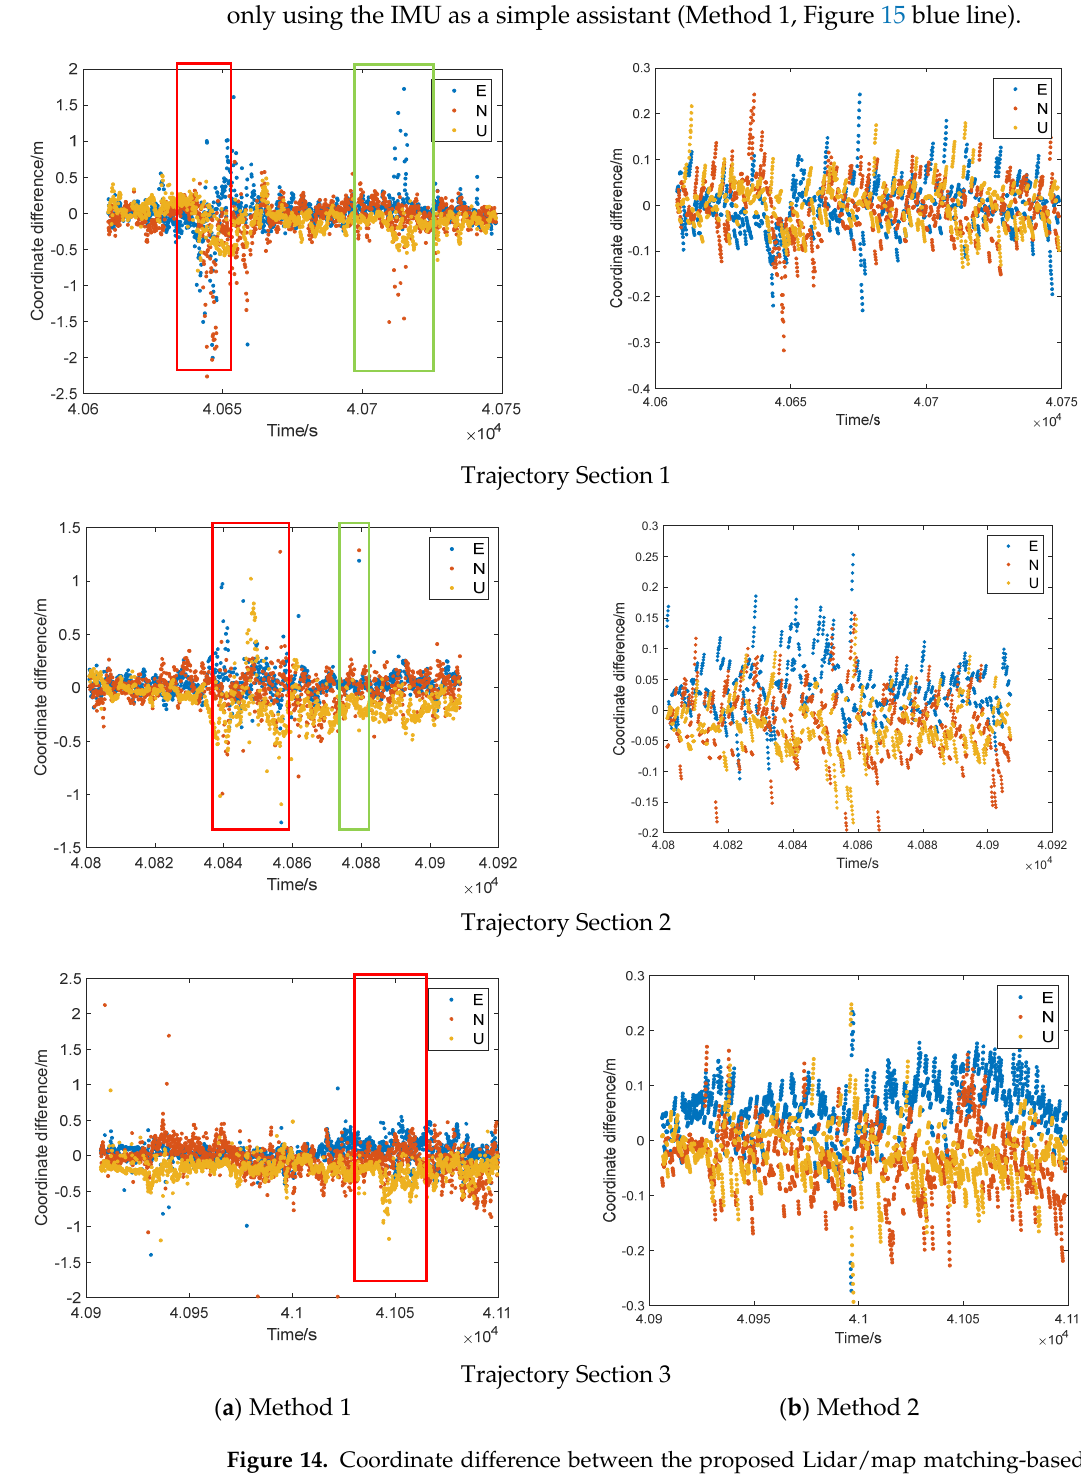
Figure 14. Coordinate difference between the proposed Lidar/map matching-based localization method and the reference GNSS/INS localization method at three trajectory sections. ( a ) Method 1: fusing IMU as an assistant sensor; ( b ) Method 2: fusing IMU using the EKF-based tightly coupled method. The red and green boxes indicate epochs with big coordinate difference with different timestamps.